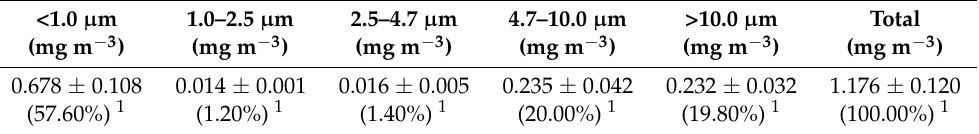
Table 2. Dust size distribution (Means ± SD) in the airborne E. coli survivability test.